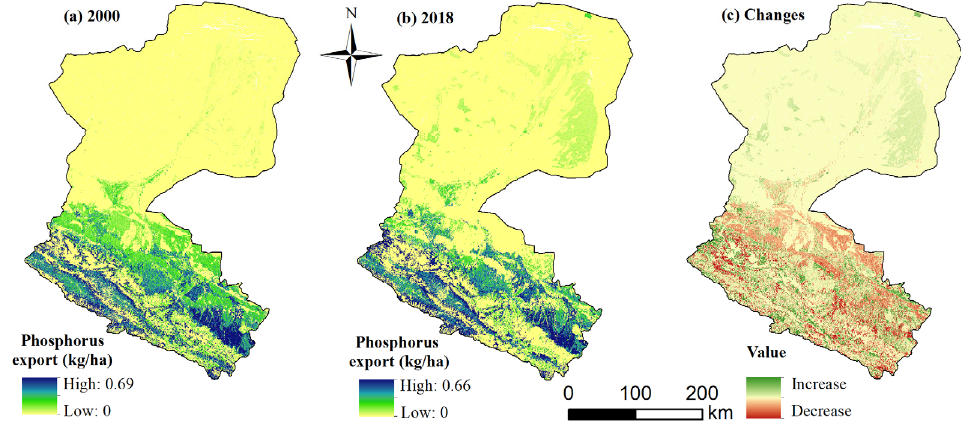
Figure 9. Spatial distribution and changes in phosphorus export from 2000 to 2018 ( a ): phosphorus export in 2000; ( b ): phosphorus export in 2018; ( c ): changes from 2000 to 2018.